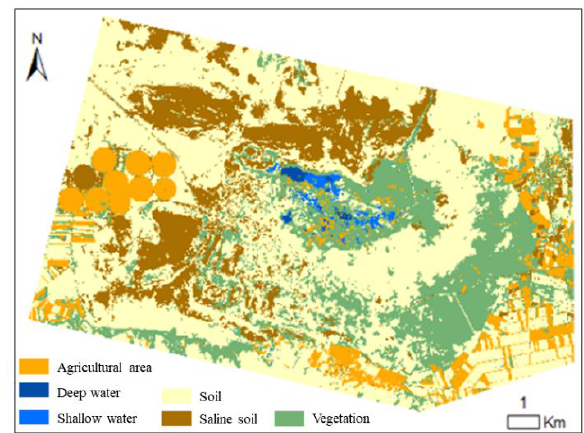
Figure 8. a) Thematic map produced from Worldview-3 with SVM classifier